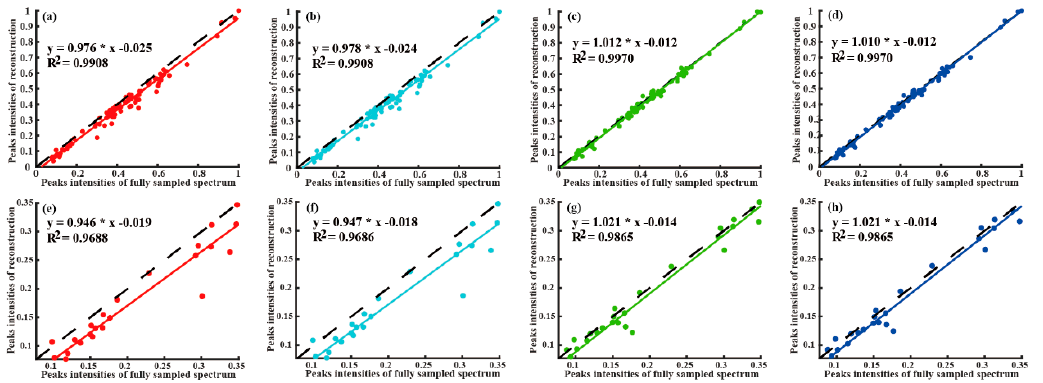
Figure 7. Peak intensity correlation between fully sampled spectrum and reconstructed spectra on the 2D HSQC of GB1. ( a – d ) are correlation plots of all peaks using LRHM, LRHMF, SLS, and SLSMF, respectively. ( e – h ) are correlation plots of low-intensity peaks using LRHM, SLS, and SLSMF, respectively.